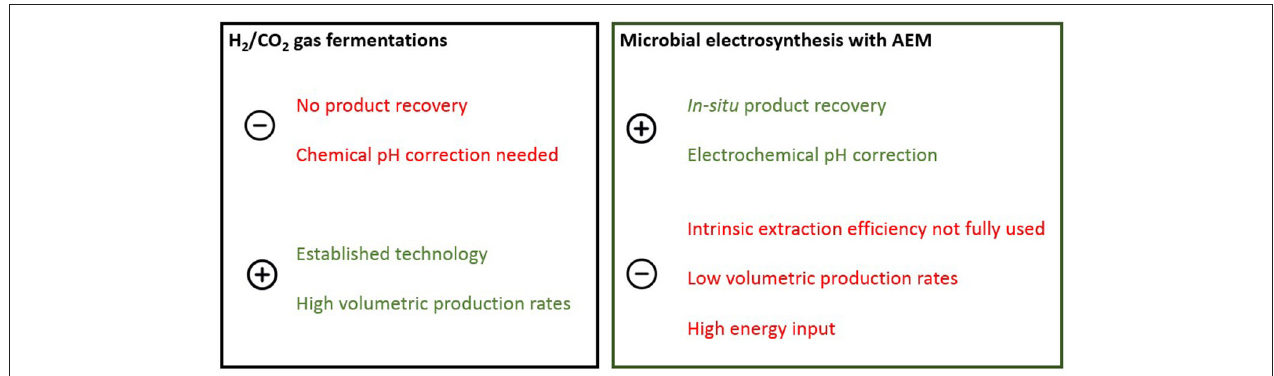
FIGURE 3 | Benefits and drawbacks of gas fermentation and microbial electrosynthesis as CO 2 -based production platforms. The coupling of both technologies results in a hybrid reactor configuration that combines the product recovery and pH stabilizing ability with the maturity and productivity of gas fermentation.